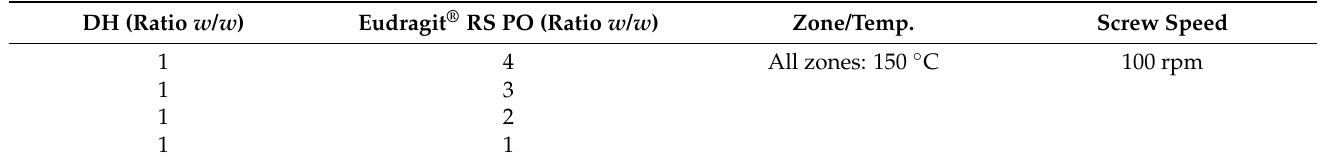
Table 3. Formulation compositions and processing parameters for the Eudragit ® RS PO (E-RS) carrier. DH (Ratio w / w )